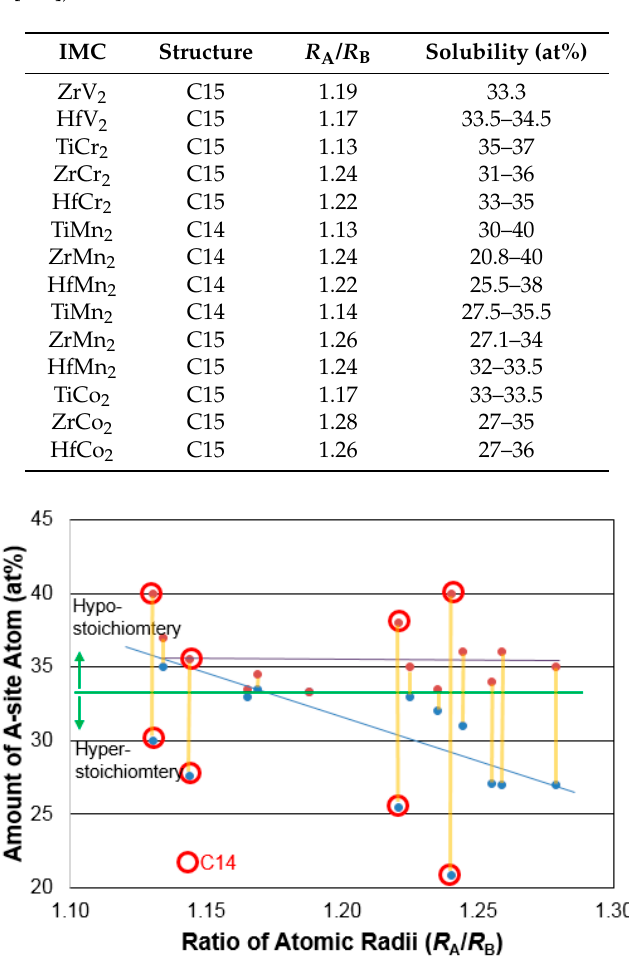
Table 9. Solubility (range of A-site atom concentration in at %) of Laves phase IMCs (radius from [148] and solubility from [257]).